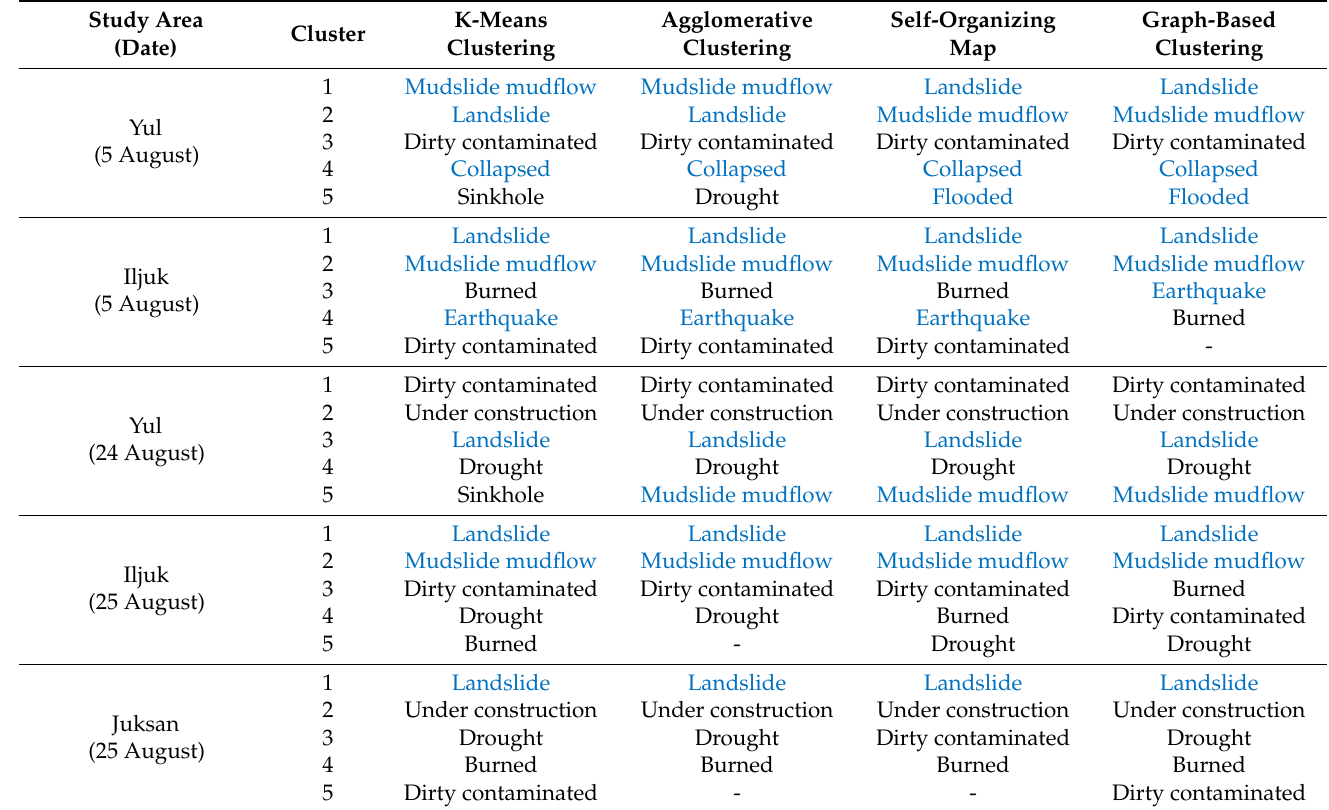
Table 3. Result of incident detection through clustering approaches. Blue indicates the filtered results by Table 1. Study